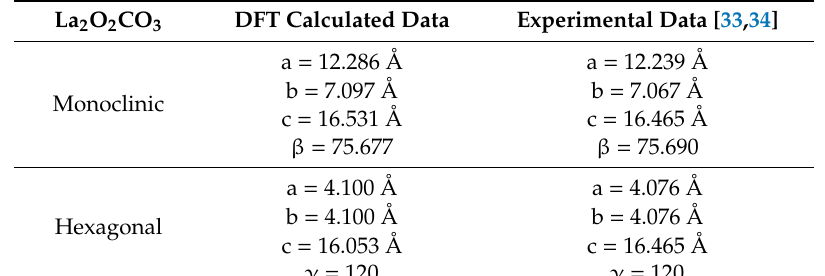
Figure 6. Density functional theory (DFT) total energy (per formula unit) of La 2 O 2 CO 3 in the hexagonal structure for three c / a values. Table 2. Lattice constants of La 2 O 2 CO 3 in monoclinic and hexagonal structures. The experimental lattice data of monoclinic [34] and hexagonal [35] structures are available from the literature.